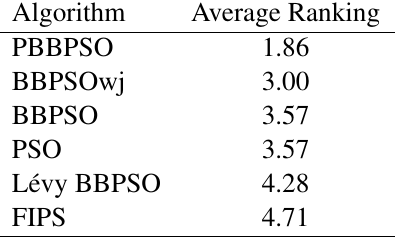
Table 4. Average ranking